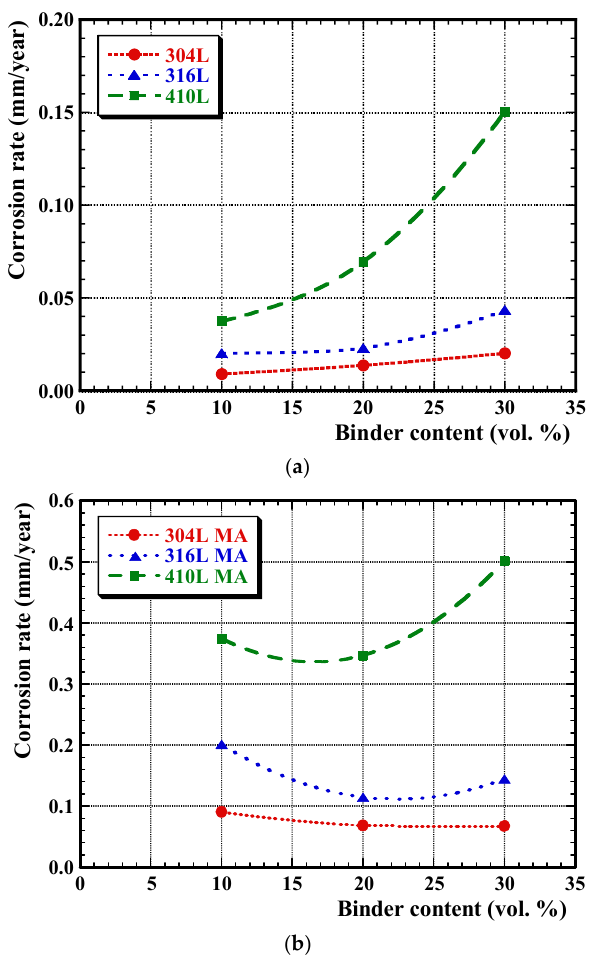
Figure 4. ( a ) The effects of binder composition and content upon the Tafel-derived corrosion rates for the TiC–stainless steel cermets; ( b ) Data in ( a ) replotted in terms of the “modified area” (MA) approach, following the methodology proposed by Hochstrasser-Kurz [22].